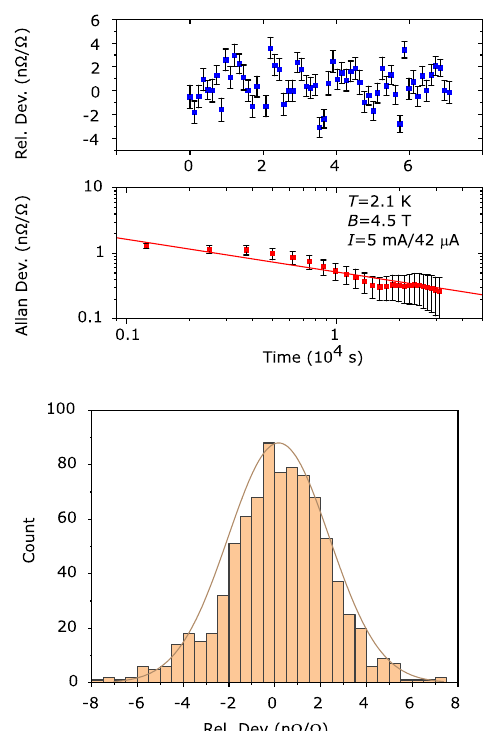
representing one standard deviation. d The corresponding Allan deviation, with estimated error (see Methods). The standard deviation of the mean is limited by Allan to ~0.2n Ω / Ω . e Mean relative deviation for direct comparison between Hall bar and array, calculatd from precision measurements like in a . The purple data represent positive fl ux density direction, while green represent negative fl ux den- sity direction. The error bars represent one standard deviation of the mean, taken from Allan deviation at 10 4 s (like d ). The measurements were taken at three dif- ferent fl ux density strengths (4.5,5.0 and 5.5T), but the data hasbeen offset in the x-axis for clarity. f Histogram of the data which produced the means in e . Each count represents one 20min long CCC-reading. The distribution is normal and centered around 0.17n Ω / Ω